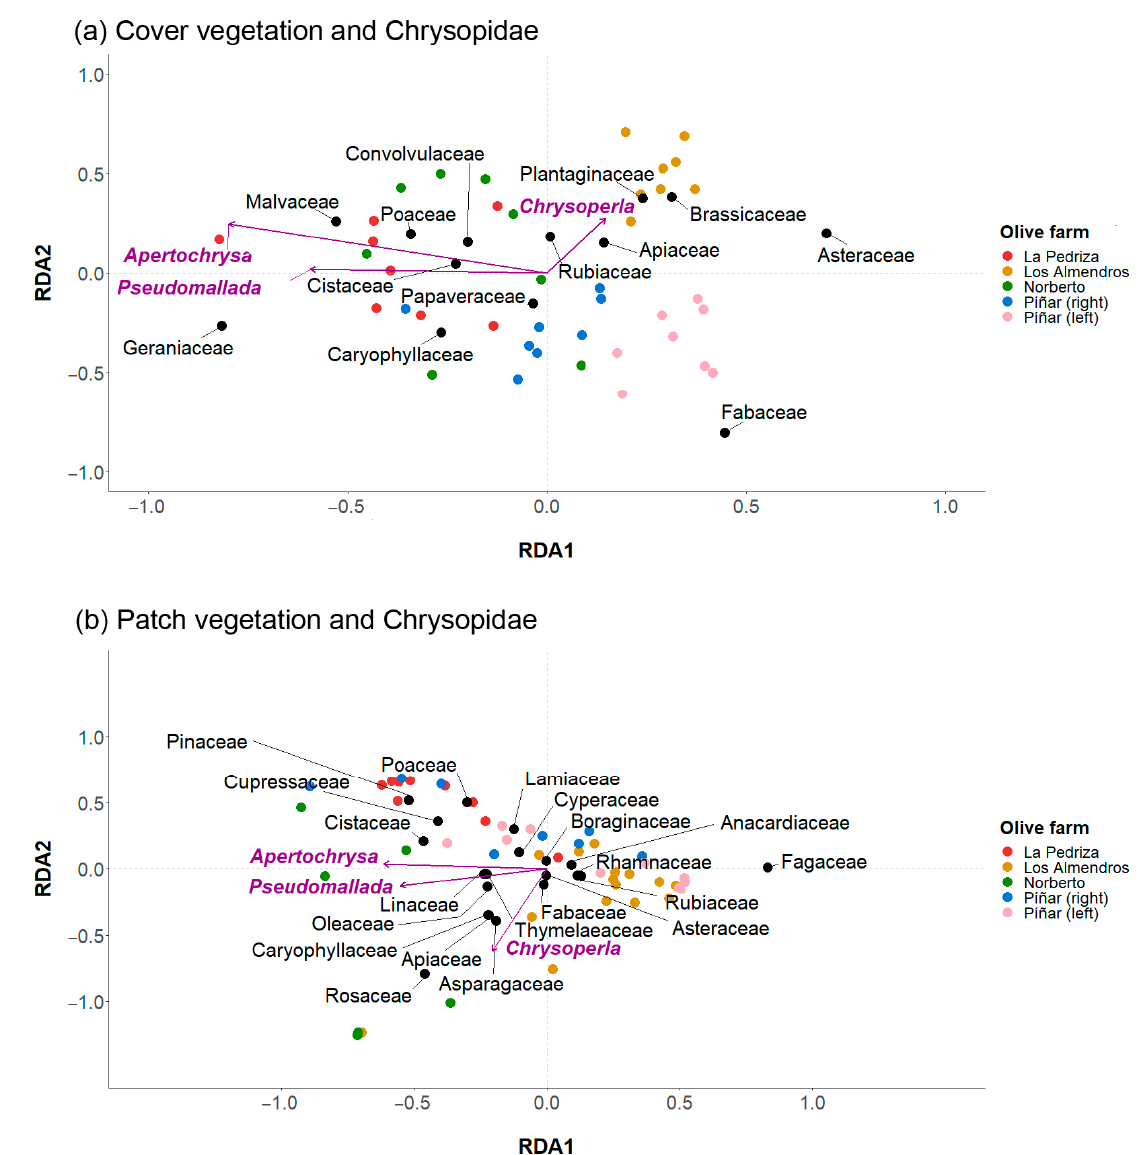
Figure 3. Redundancy analysis (RDA) biplot representing plant cover per family (%) in each transect and the number of Chrysopidae genera collected in each olive farm ( a ) in the cover vegetation and ( b ) in the patch vegetation. Chrysopidae genera are represented by purple arrows, olive farms by coloured dots and plant families by black dots.